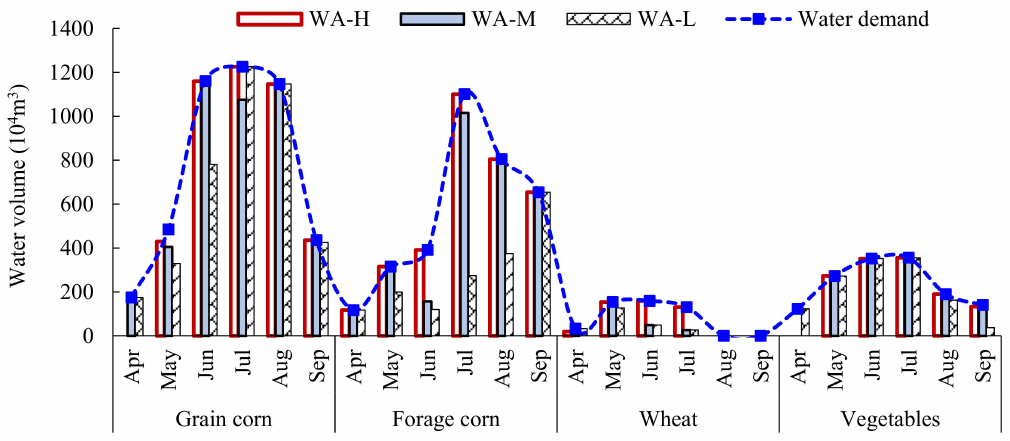
Figure 5. Irrigation water allocation for each crop. (Note: WA-H, WA-M, and WA-L indicate water allocation in high flow level, middle flow level, and low flow level,